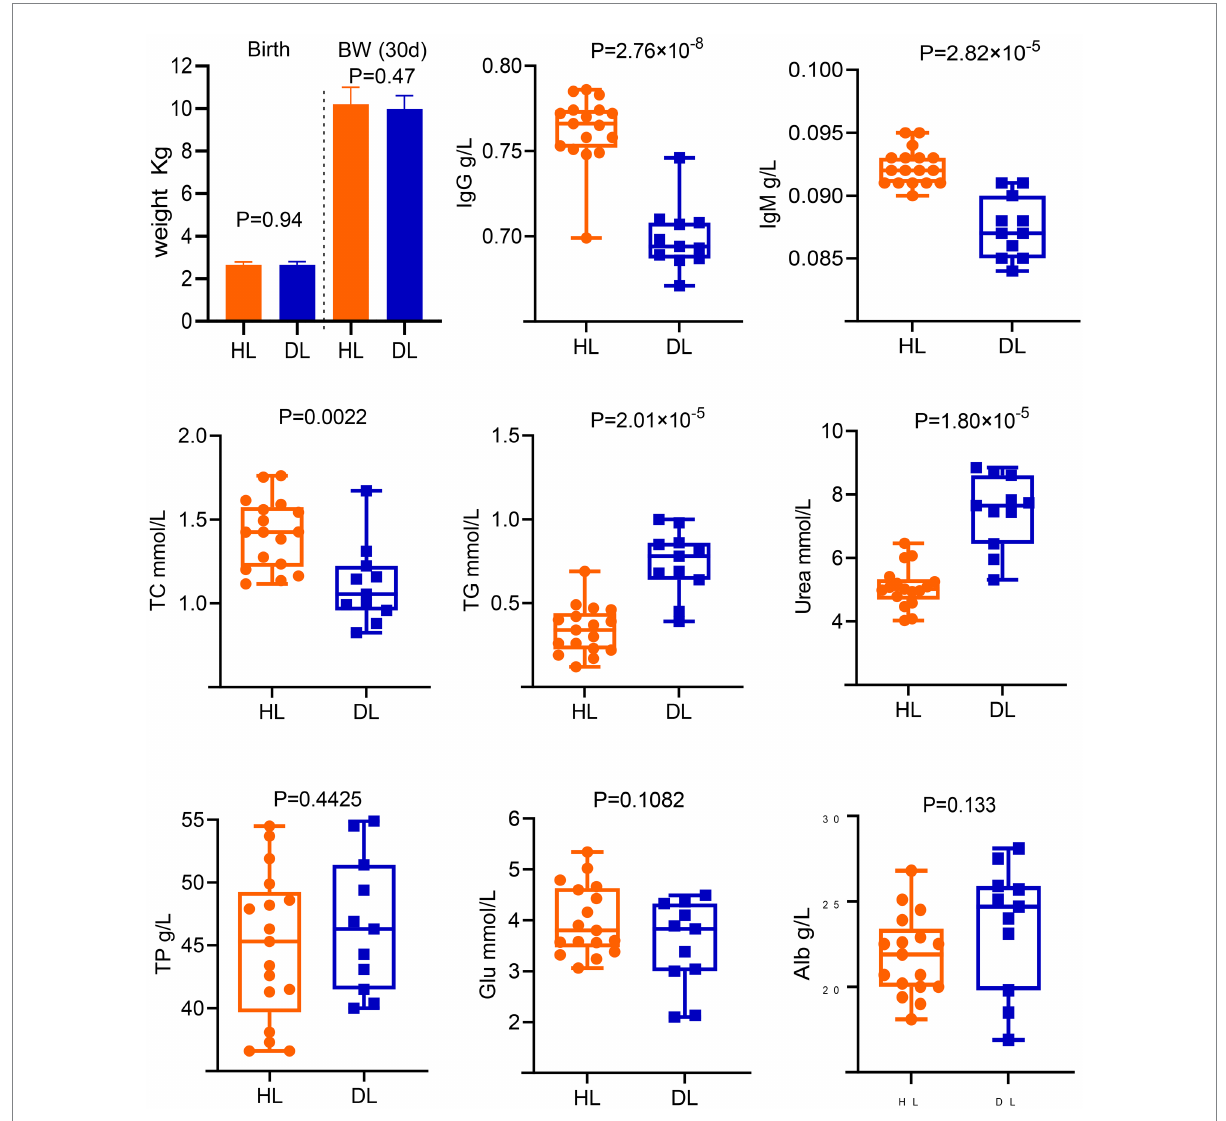
FIGURE 1 Determination of serum biochemical indices and immunological parameters of diarrheic and healthy